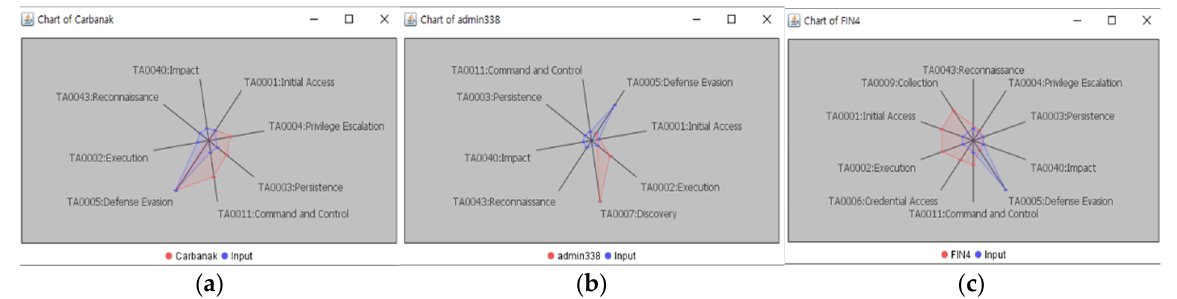
Figure 12. Radar chart of the difference between the tactics used by the group and the new input tactics. ( a ) Carbanak, ( b ) admin338, and ( c ) FIN4.